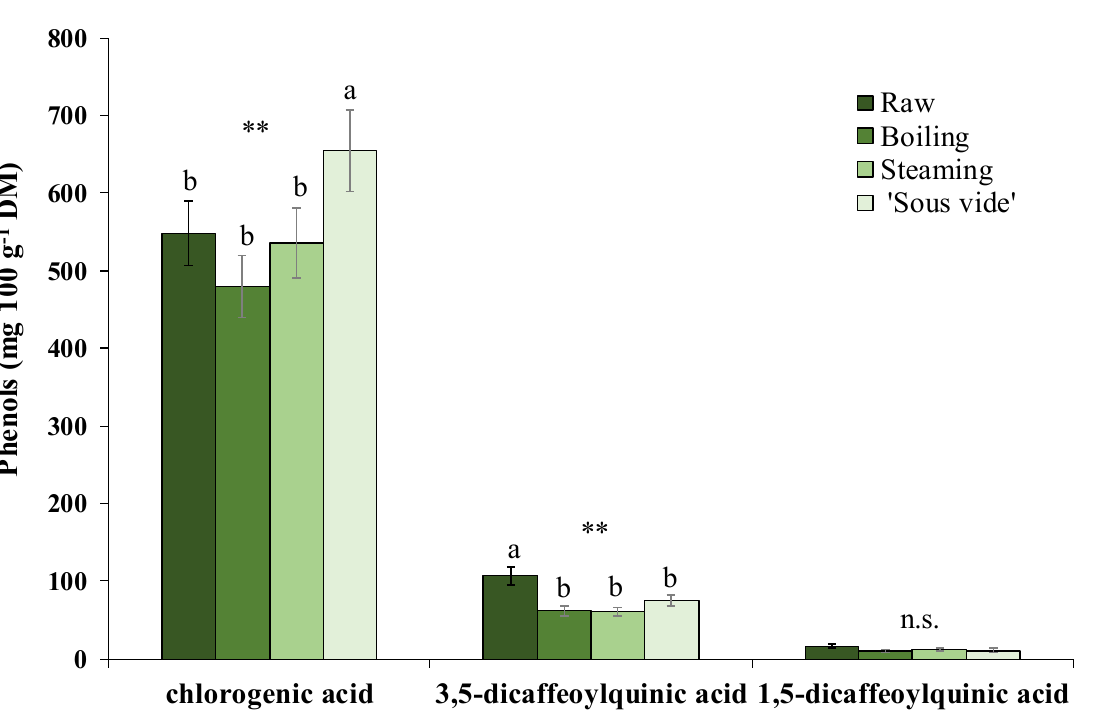
Figure 4. Main phenolic compounds identified in golden thistle midribs raw and cooked by boiling, steaming, and ‘sous vide’. Vertical bars indicate the standard deviation. Different letters indicate statistically different values (α = 0.05) between treatments. Significance: n.s., not significant; **, sig- nificant at p ≤ 0.01.